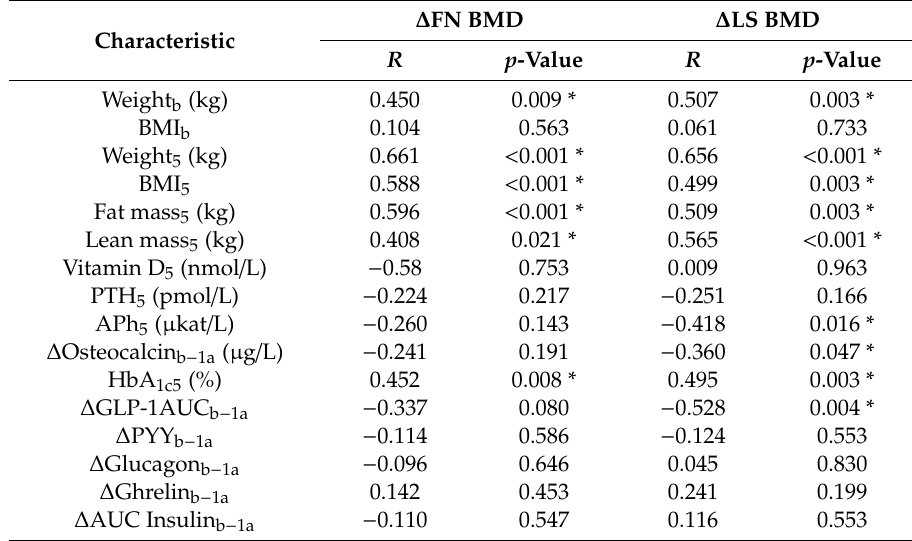
Table 3. Correlations of BMD changes at the femoral neck and lumbar spine with body composition, biochemical parameters and hormonal changes after